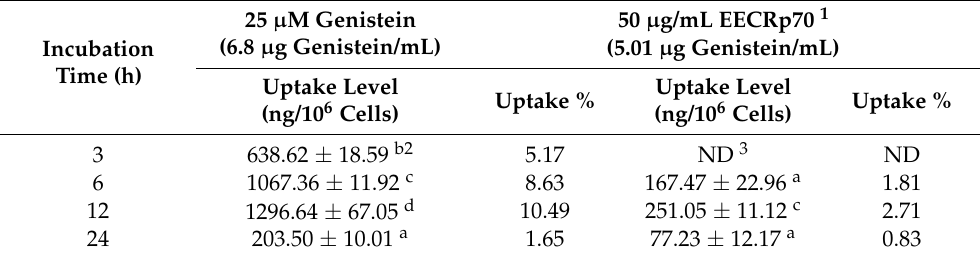
Table 3. Determination of cellular uptake of genistein in SCC25